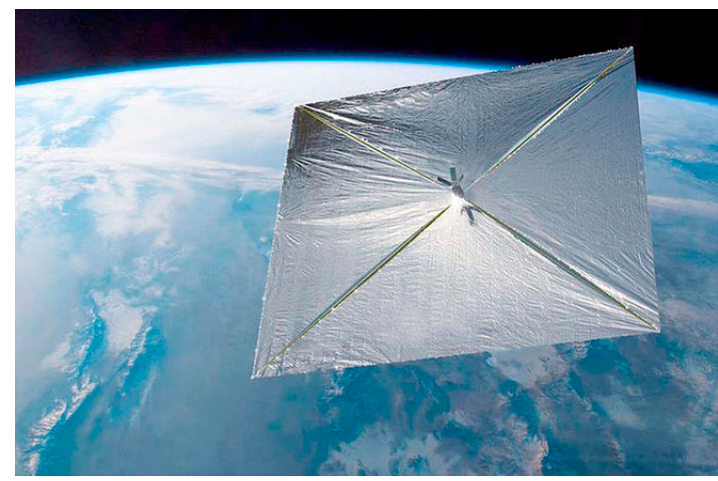
Figure 23. Solar Sail Attached to a 3U CubeSat in Orbit [40].